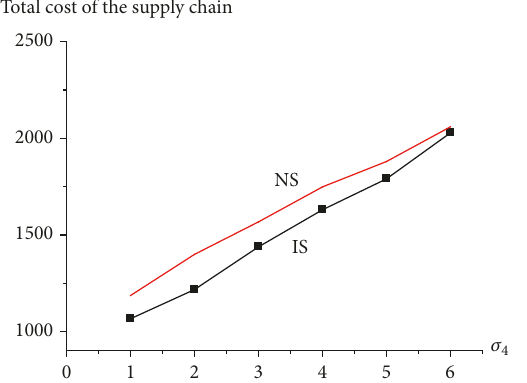
Figure 12: Transportation uncertainty versus the supply chain’s costs under two